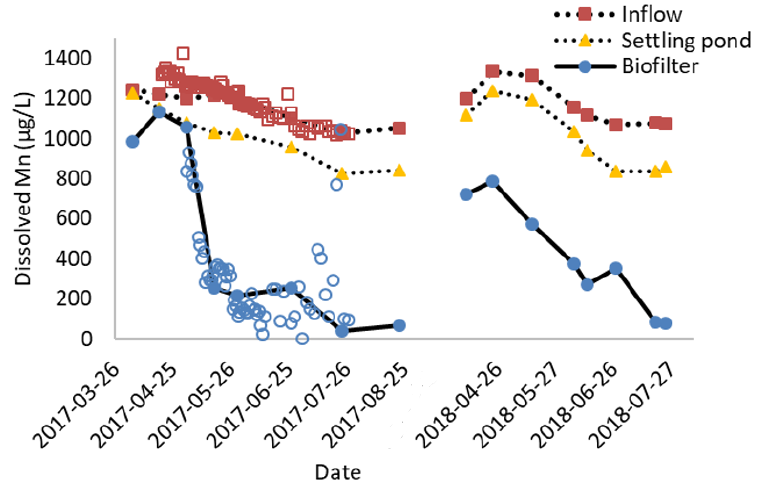
Figure 5. Dissolved manganese concentration.